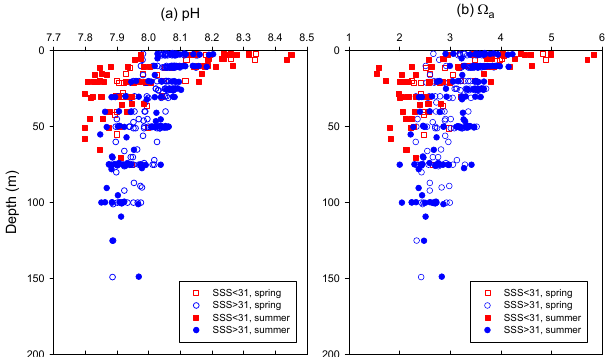
Fig. 10. Depth profiles of (a) pH 25 and (b) (cid:127) a over the East China Sea shelf in spring and summer 2009. Squares and circles denote the data in (SSS < 31) and out (SSS > 31) of the Changjiang plume area, respectively. SSS: sea surface salinity.